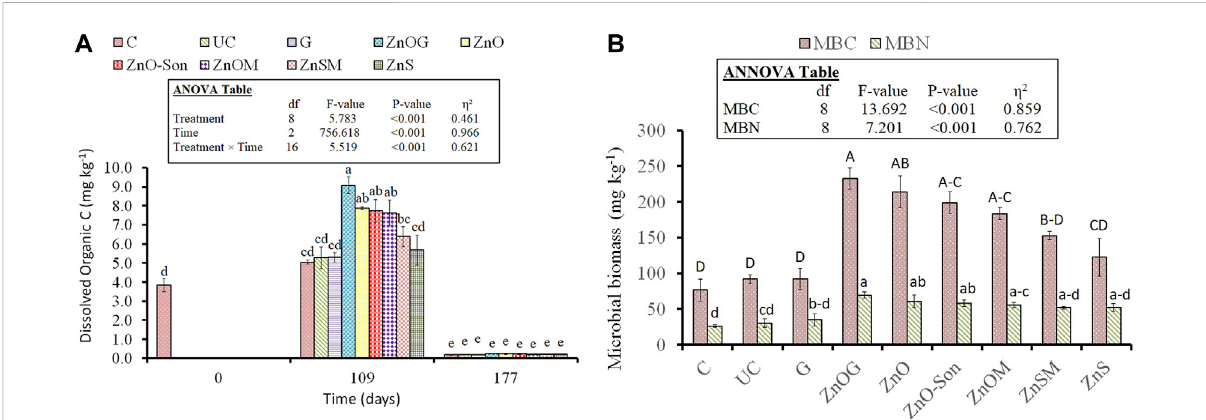
FIGURE 7 Soil-available carbon (A) and soil microbial biomass carbon (MBC) and nitrogen (MBN) (B) . Small letters over each bar indicate the difference among treatments at a 5% probability level. Error bars represent the standard error of the mean ( n = 3). Inset in the fi gure represent result of the analysis of variance